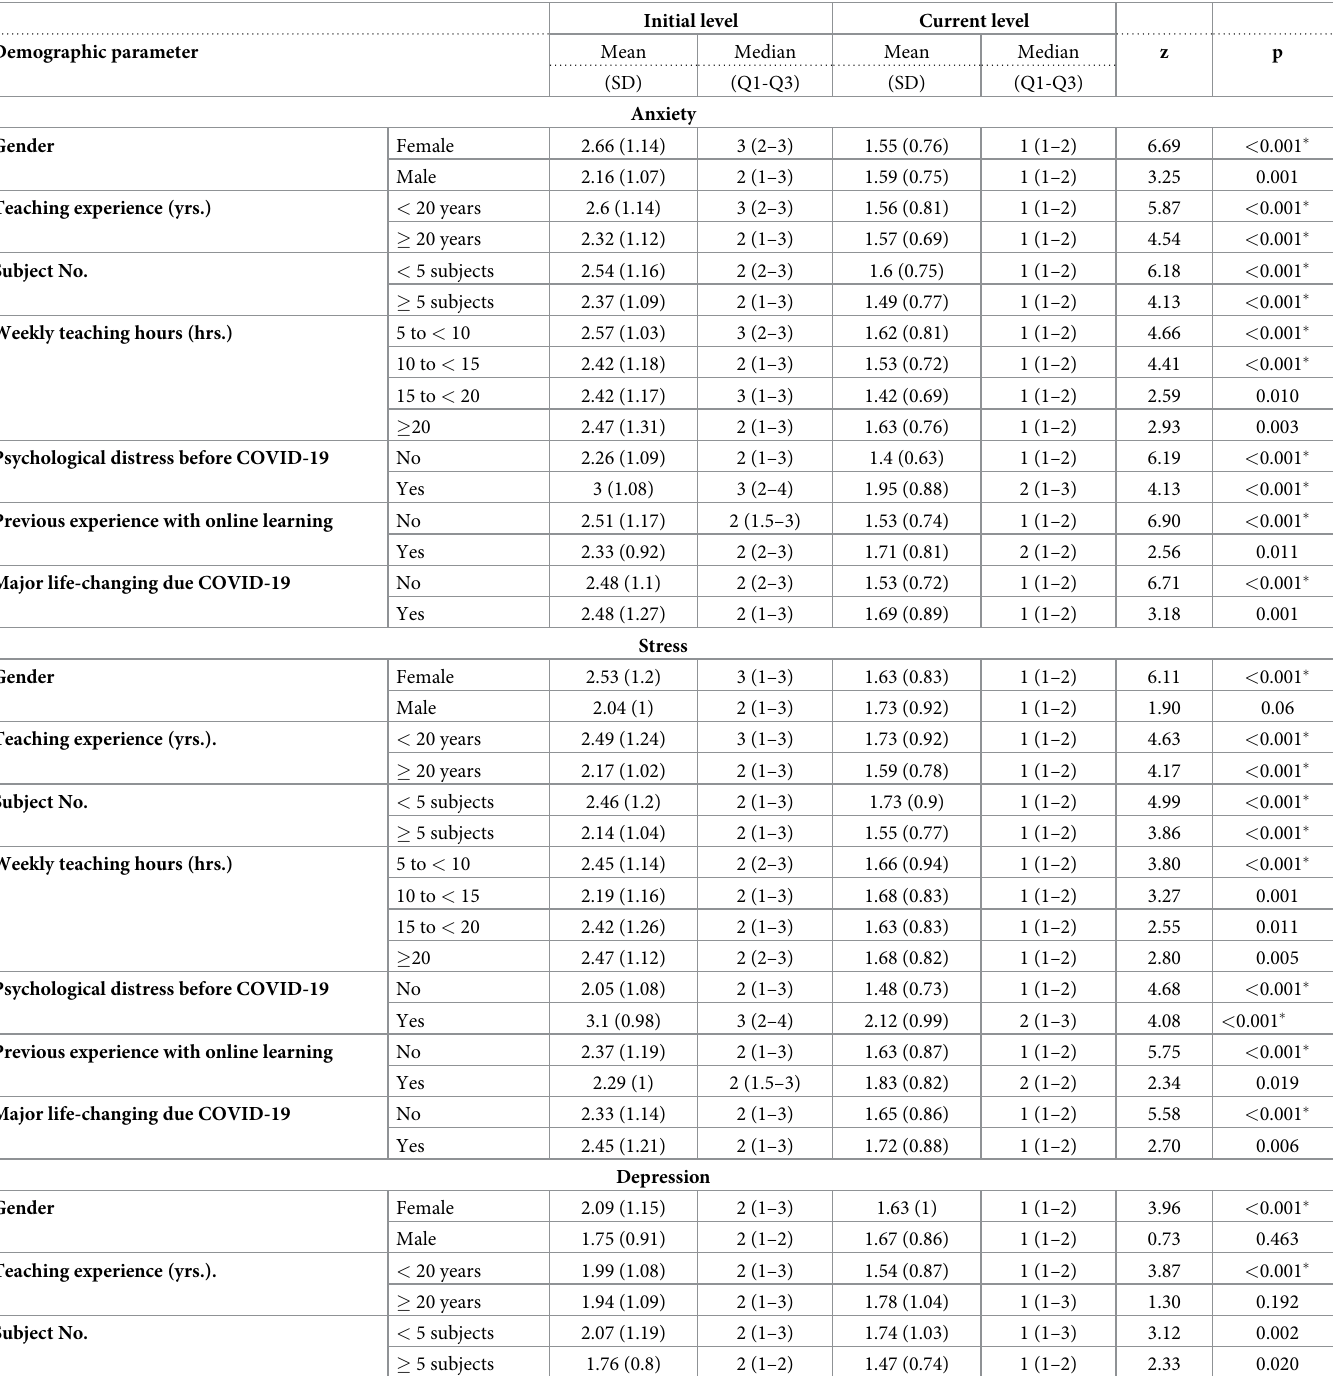
Table 2. Intra-differences analysis between initial and current levels of anxiety, stress, and depression using paired Wilcoxon signed-rank test with Bonferroni-